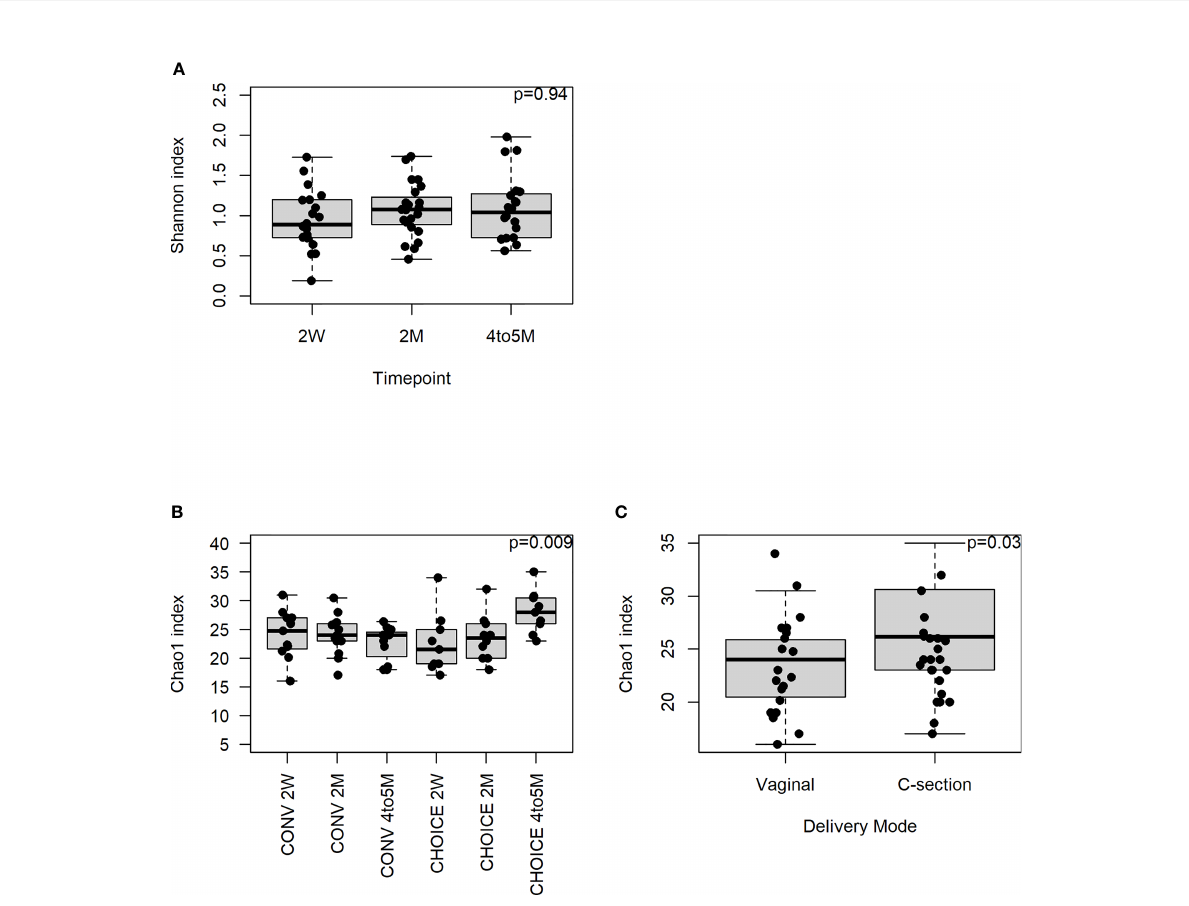
FIGURE 1 Infant microbiome alpha diversity at the family level. A repeated-measures mixed-effects model was used to test for statistical signi fi cance. (A) Association of Shannon diversity and infant age (n=20, 2-week; n=23, 2-month; n=20, 4 – 5-month). (B) Chao1 index association with diet group over time (n=11, CONV 2-week; n=13, CONV 2-month; n=11, CONV 4 – 5-month; n=9, CHOICE 2-week; n=10, CHOICE 2-month; n=9, CHOICE 4 – 5-month). (C) Association of Chao1 index with delivery mode (n=17, vaginal; n=7,